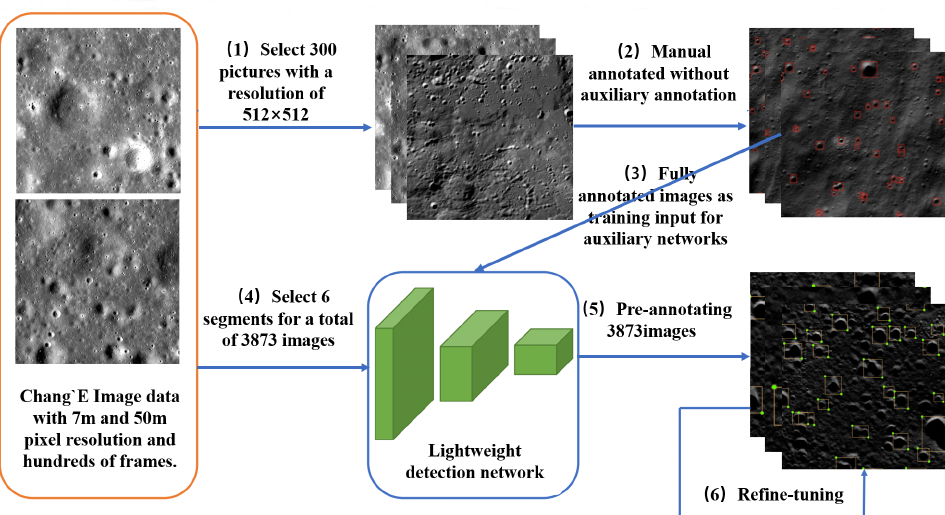
Figure 4. Illustration of the auxiliary annotation process. (1) The selection of 300 divided images with a resolution of 512 × 512; (2) the annotation process of the 300 pictures with the annotation tool; (3) the fine-tuning process of the pre-trained lightweight detection network using labeled images; (4) the selection (6 frames) and decomposition process (splitting the selected frames down into 3873 pictures with a resolution of 512 × 512); (5) the pre-annotating of the exploded pictures; (6) the manual fine-tuning process of pre-annotated